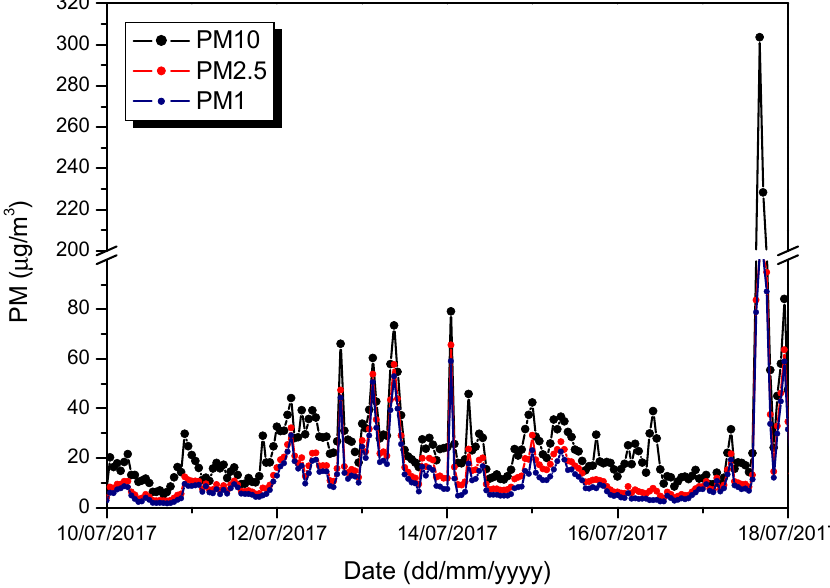
Figure 6. Daily averaged values of the different PM fractions (in µ g m − 3 ) monitored continuously by the OPC from 10 to 17 of July 2017.